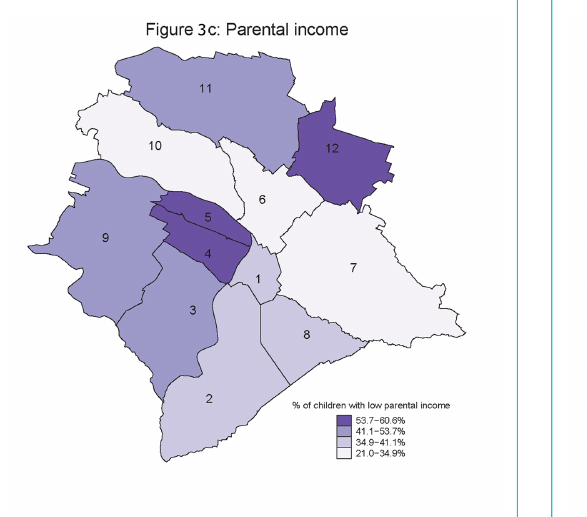
Figure 3c: Map of the City of Zurich showing the proportion of chil- dren with low parental income in different districts (intensity of the